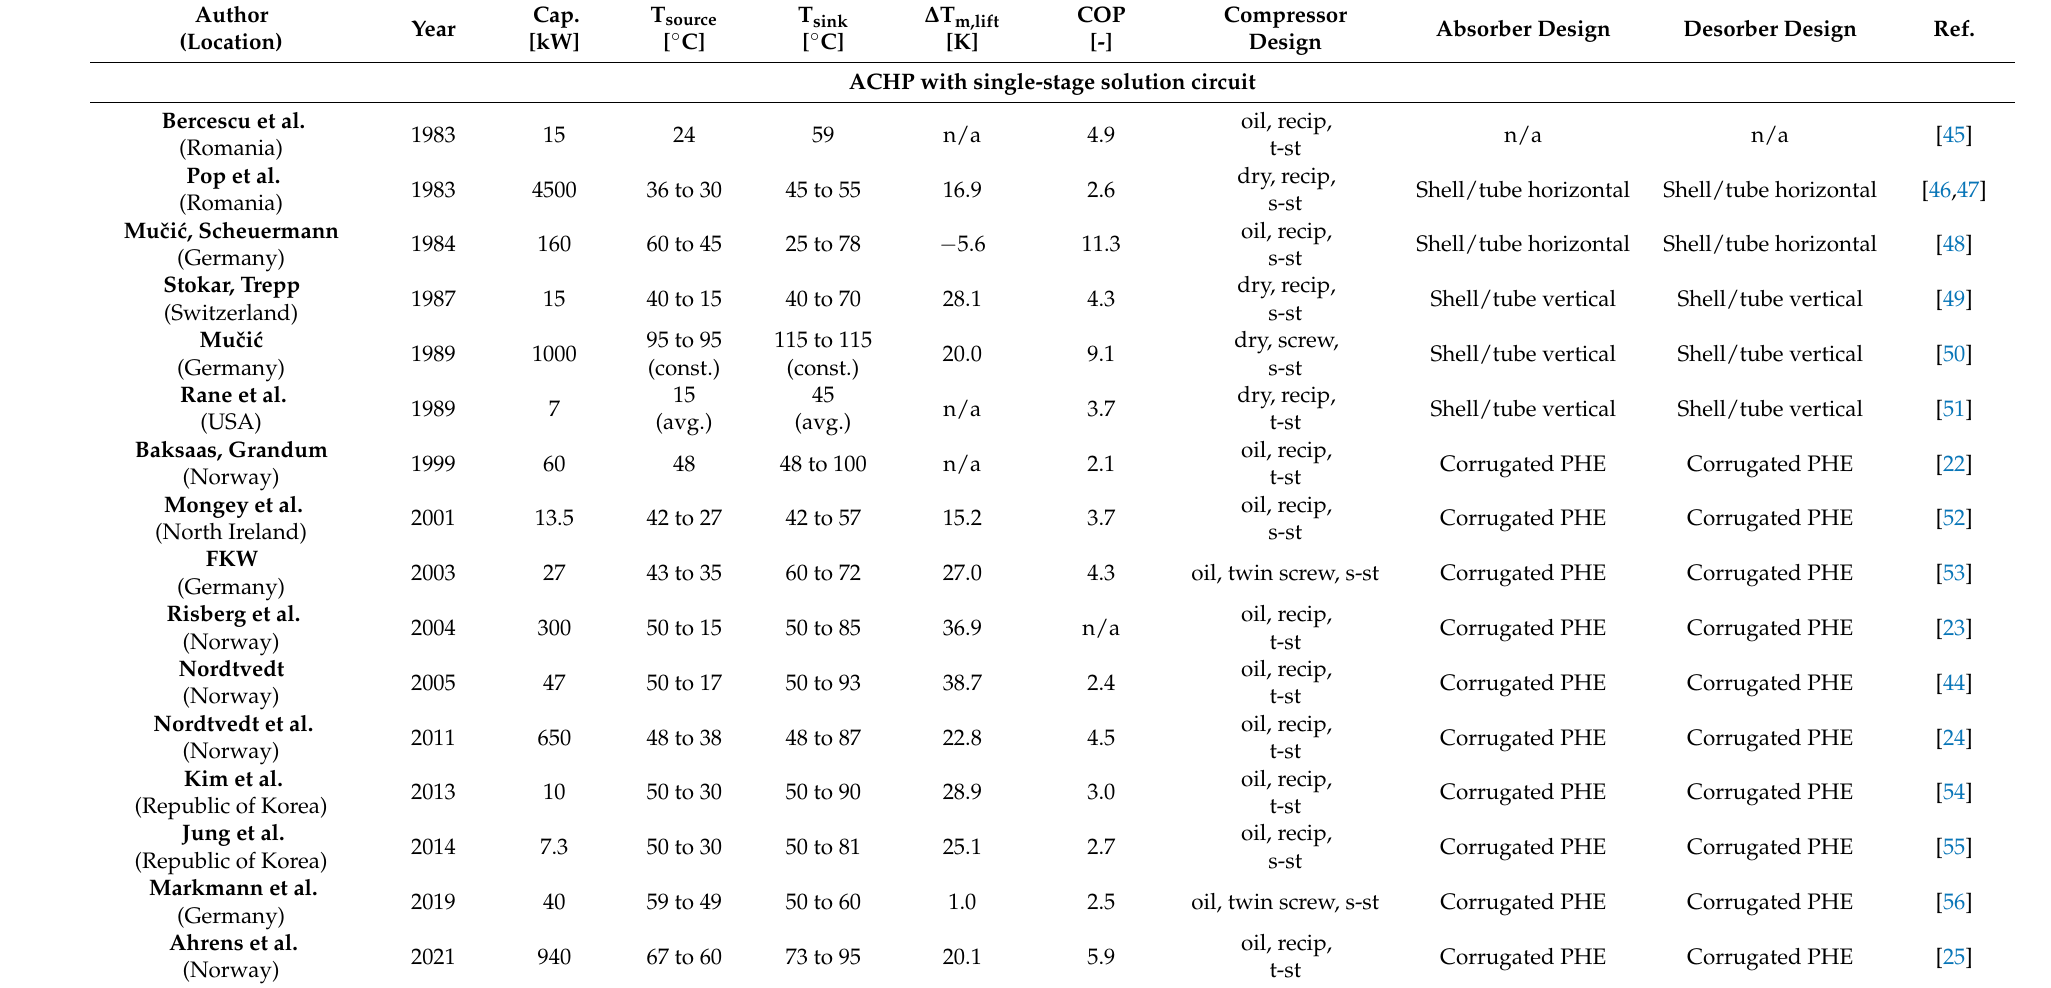
Table 1. Overview of experimental investigations on ammonia-water absorption–compression heat pump